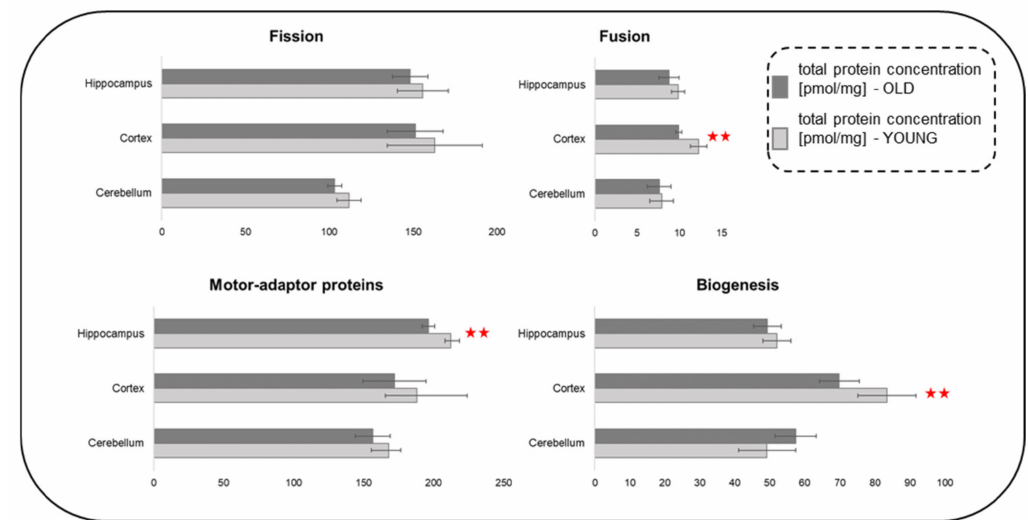
Figure 7. Proteins regulating mitochondrial network dynamics—fusion fission, motility and biogenesis. The statistically significant changes between age groups are indicated (** p < 0.01). Abbreviations: YOUNG—1-month-old and OLD— 22-month-old